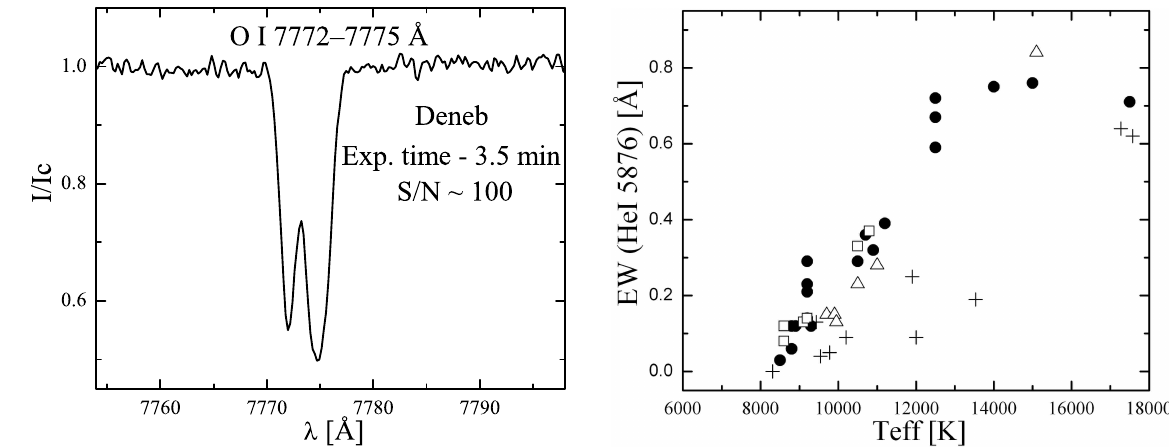
Fig. 1. Left panel: Example of a part of the longest wavelength order of a spectrum of α Cygni taken at TCO. This part contains the luminos- ity sensitive triplet of O i lines. Although two of the three lines are blended (the right line), their combined EW is usually used to measure the object’s luminosity. Right panel: Relationship between the EW of the He i 5876 Å line and effective temperature for stars of various lu- minosity types: filled circles: – i a, squares – i ab, triangles – i b, pluses – iii and v . Observational data were obtained at TCO, temperatures were taken from the literature. Table 1. Some databases and archives that contain spectra of Be stars.